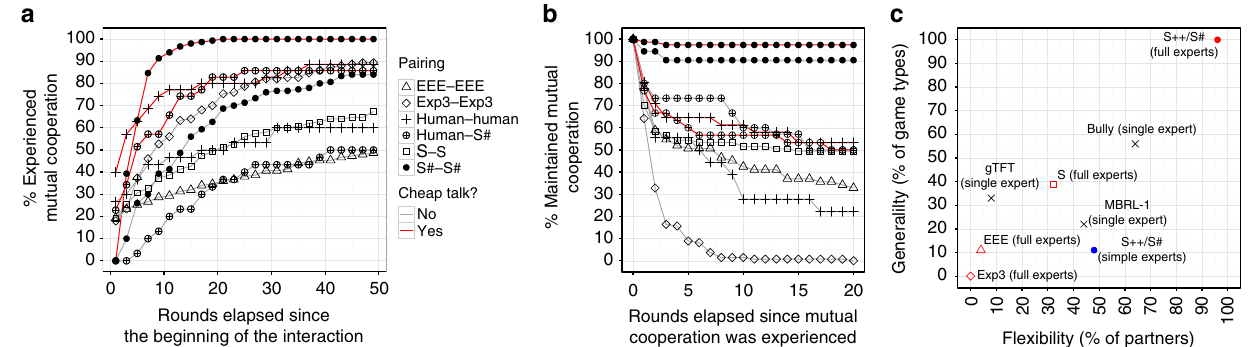
Fig. 7 Comparisons of people and algorithms with respect to various characteristics. a Empirically generated cumulative-distribution functions describing the number of rounds required for pairings to experience two consecutive rounds of mutual cooperation across three games (Chicken, Alternator Game, and Prisoner ’ s Dilemma). Per-game results are provided in Supplementary Note 7. For machine – machine pairings, the results are obtained from 50 trials conducted in each game, whereas pairings with humans use results from a total of 36 different pairings each. b The percentage of partnerships for each pairing that did not deviate from mutual cooperation once the players experienced two consecutive rounds of mutual cooperation across the same three repeated games. c A comparison of algorithms with respect to the ability to form pro fi table relationships across different games (Generality) and with different associates (Flexibility). Generality was computed as the percentage of game types (de fi ned by payoff family × game length) for which an algorithm obtained the highest or second highest average payoffs compared to all 25 algorithms tested. Flexibility was computed as the percentage of associates against which an algorithm had the highest or second highest average payoff compared to all algorithms tested. See Supplementary Note 3 for